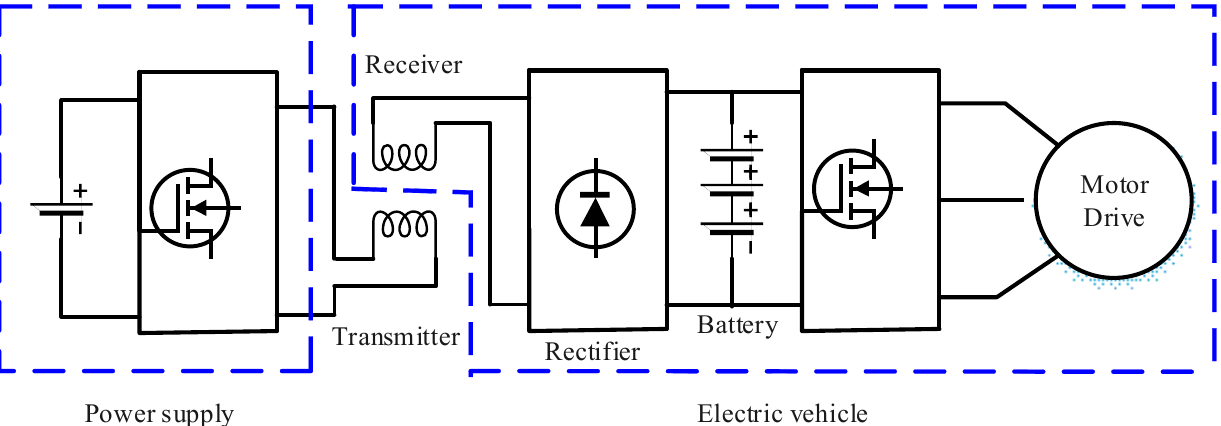
Figure 19. The layout of the WPT system in EV applications.